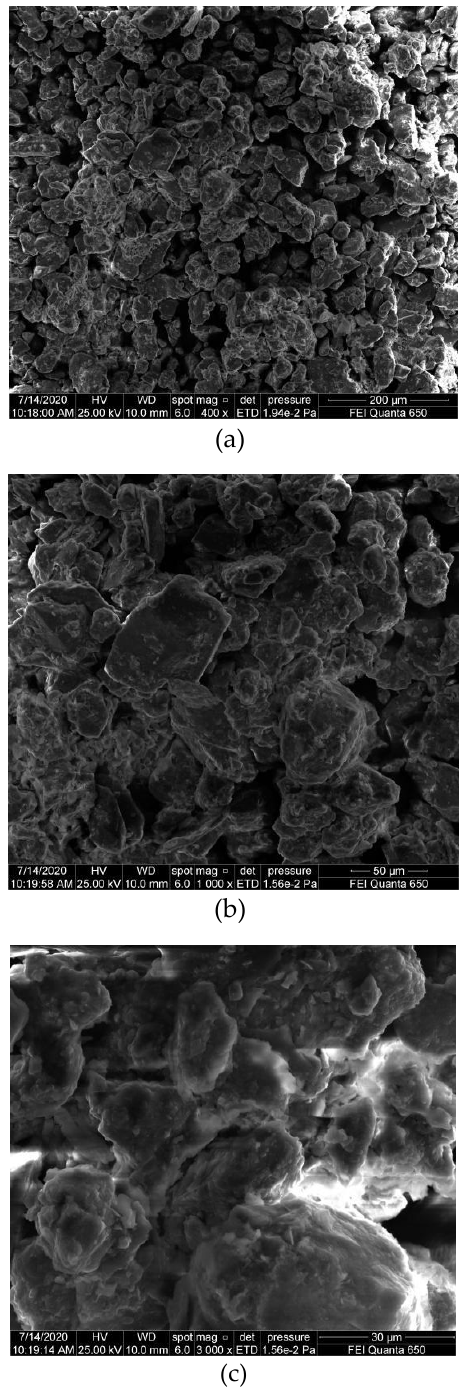
Figure 6. Micromorphology of Sample 5: ( a ) The magnification is 400; ( b ) The magnification is 1000; ( c ) The magnification is 3000.